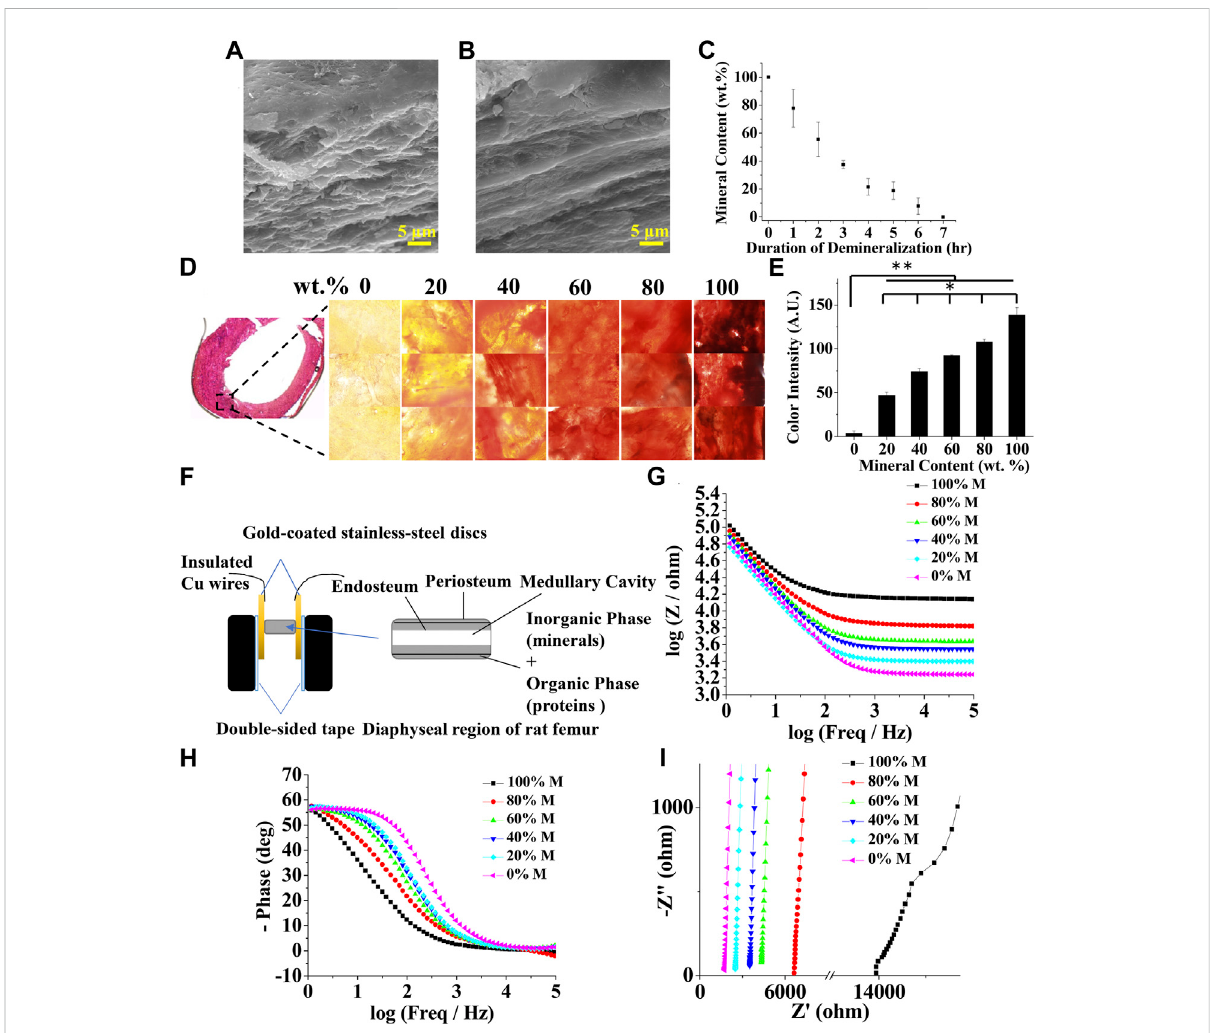
FIGURE 2 Characterization of bone mineral content and electrochemical impedance spectroscopy (EIS) at different levels of mineralization. Scanning electron microscopy (SEM) imagesof (A) intact (B) demineralized bone samples (C) Bone mineral content as a function of demineralization duration (D) Bonecryosection andalizarinredstainingat0, 20,40,60, 80,and100 wt%bonemineralcontent (E) Quanti fi edalizarinredstainingintensity asa function of bone mineral content ( n = 5, * and ** denote statistical signi fi cance of p < 0.05 and p < 0.01, respectively, analyzed by